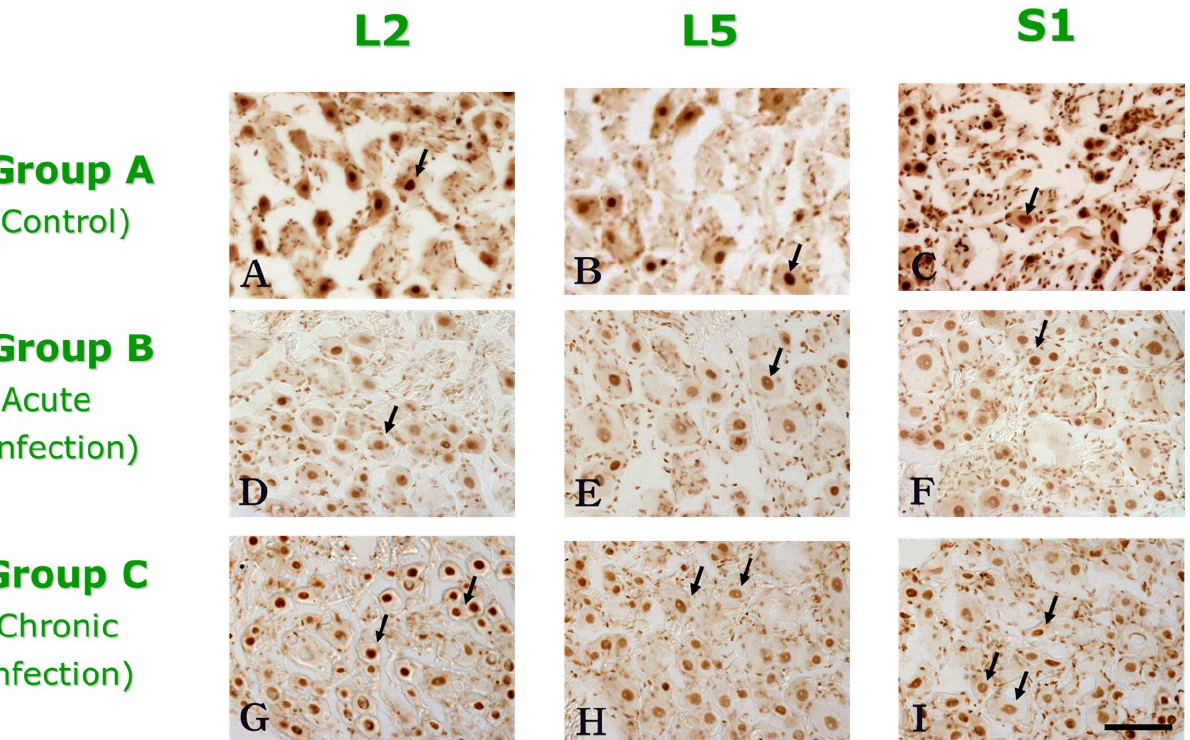
Figure 2. The expression of p-CREB in L2, L5 and S1 DRG in each group. In all groups,